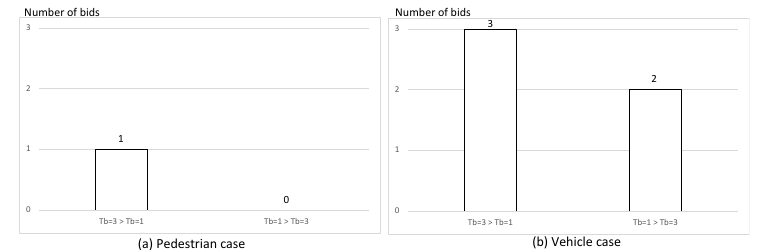
Figure 21. Number of different successful bids between 𝑇 𝑏 = 3 and 𝑇 𝑏 = 1 .